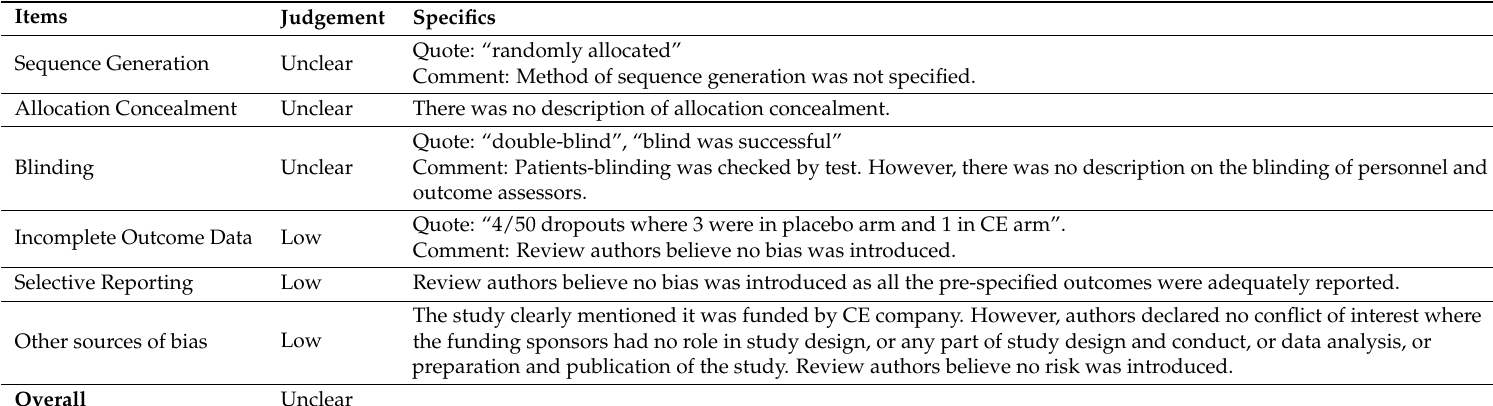
Table A7. Risk of bias assessment of Yamano 2015, [5].